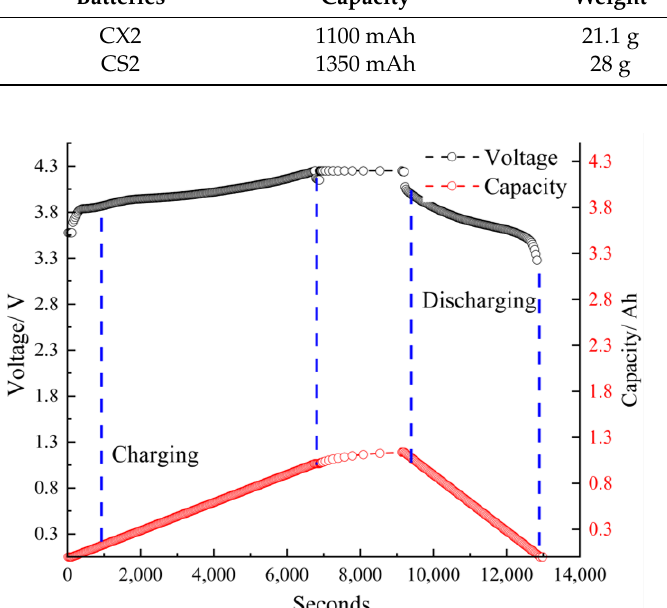
Table 2. Basic parameters of experimental batteries. Batteries